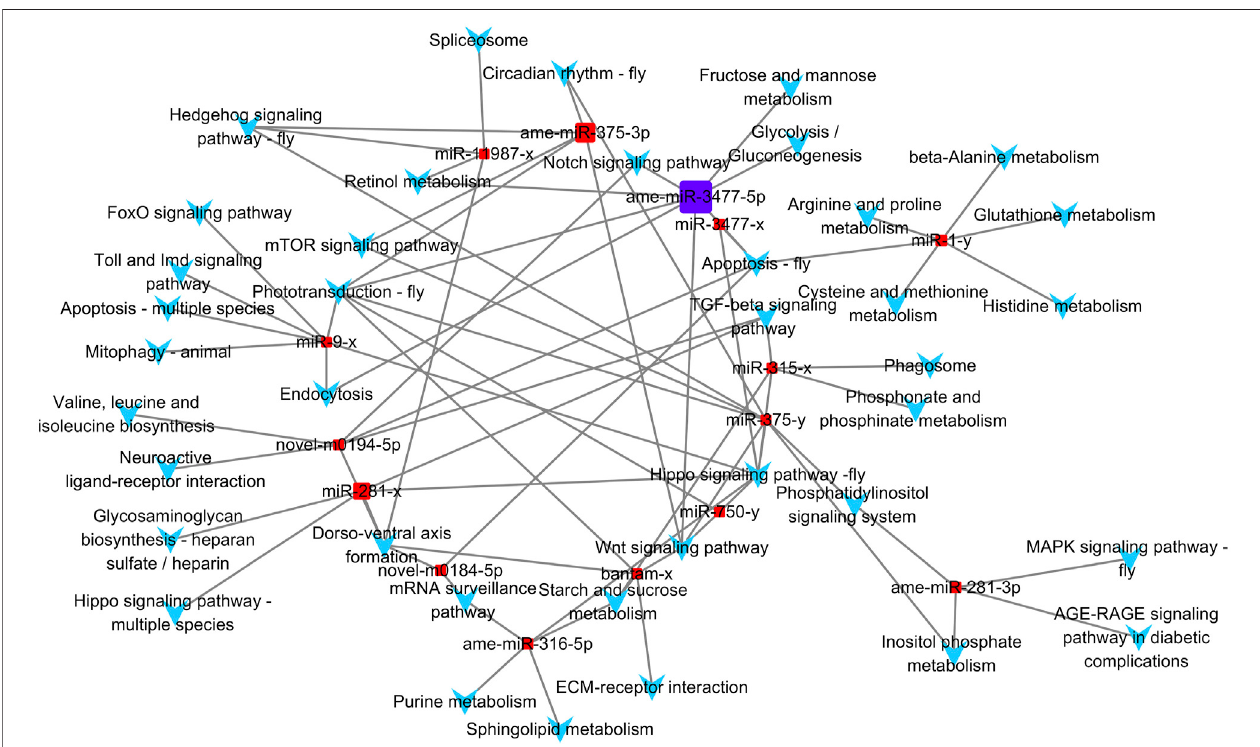
FIGURE 5 | Differential expressed miRNA and KEGG pathway network. Square nodes represent miRNAs, and arrow-shaped nodes represent pathways. The miRNA nodes ’ sizes were determined by the expression